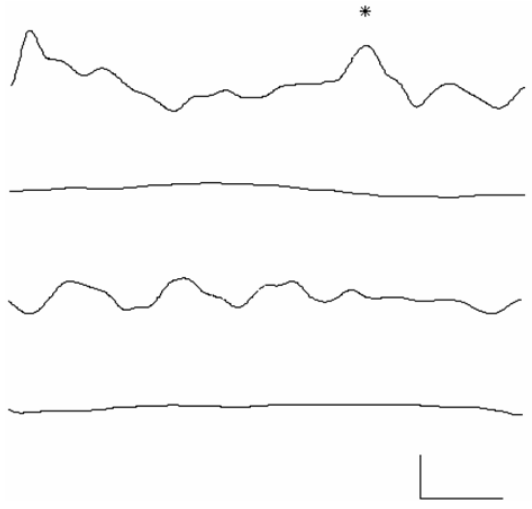
FIGURE 2 . The same patient as in Fig. 1, 1 year (up) and 2 years later (down). Same indications as in the previous